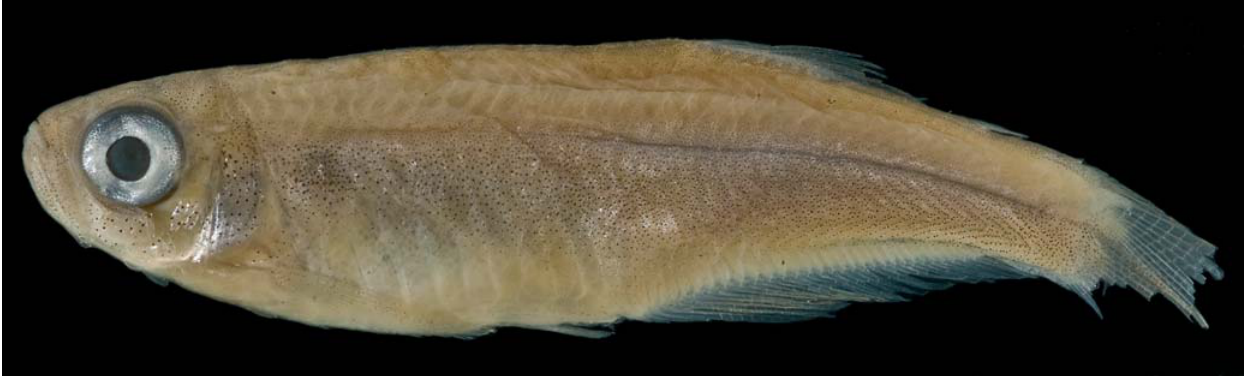
Fig. 46. Mimagoniates pulcher , female, MNRJ 4233, SL 26.3 mm SL, Brazil, Mato Grosso, “Porto Velho-São Luís de Cáceres”,